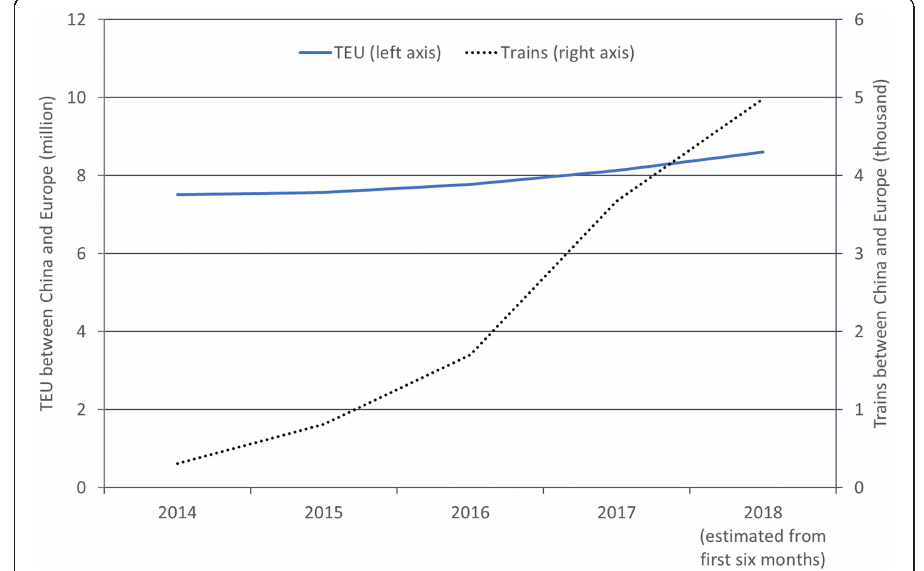
Fig. 9 Trends in TEU and trains between China and Europe (MDST, China Railway